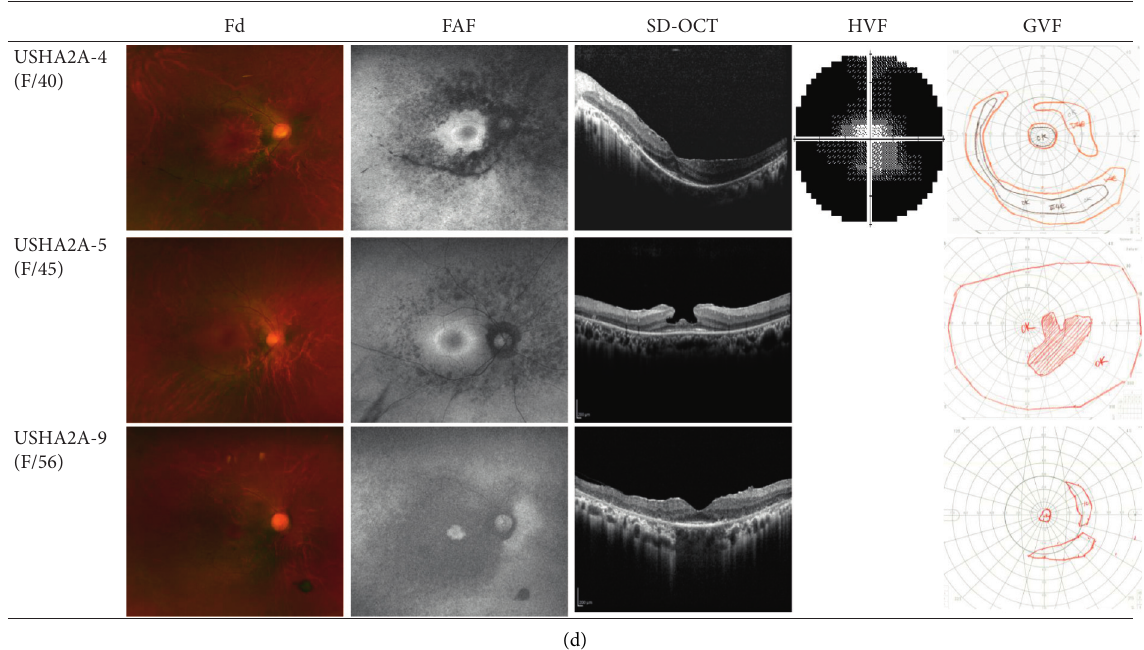
Figure 2: Disease progression patterns in retinitis pigmentosa patients carrying variants of four major causative genes. Disease progression patterns in (a) EYS-related RP: coarse pigmentation around the major vascular arcades and peripheral EZ disruption concomitant with peripheral VF constriction; (b) PDE6B-related RP: a bull’s eye pattern of FAF consistent with paracentral scotoma. CME was frequently observed. (c) RP1-related RP: peripheral demarcated hyperautofluorescence lines and aggregation of pigments concomitant with a paracentral ring-shaped scotoma in the VF were characteristic features of AD RP1-RP. Perivascular pigmentation with macular atrophy was prominent in AR RP1-RP. (d) USH2A-related RP: fine pigmentation around the vascular arcade combined with paracentral scotoma in the VF. An ERM was found frequently. The images are presented in order of increasing patient age. RP, retinitis pigmentosa; EZ, ellipsoid zone; VF, visual field; CME, cystoid macular edema; ERM, epiretinal membrane; AD, autosomal dominant; AR, autosomal recessive; Fd, fundus photography; FAF, fundus autofluorescence; SD-OCT, spectral-domain optical coherence tomography, HVF, Humphrey visual field test, GVF; Goldmann visual field